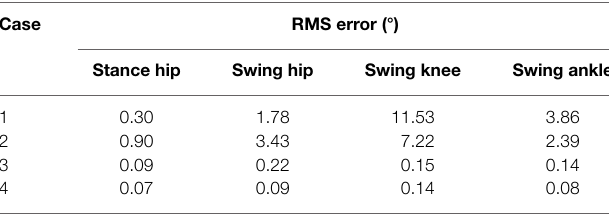
TABLE 1 | The root mean squared (RMS) error for the four simulated cases . Case RMS error (°) Stance hip Swing hip Swing knee Swing